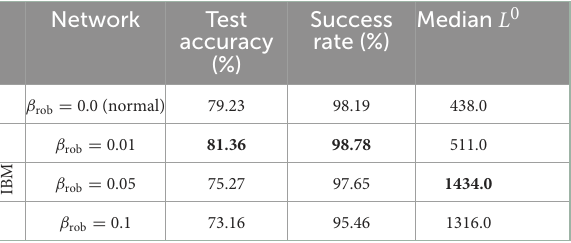
TABLE 3 Training with a small robustness term ( β rob = 0.01) increases generalization and therefore improves the test accuracy of the